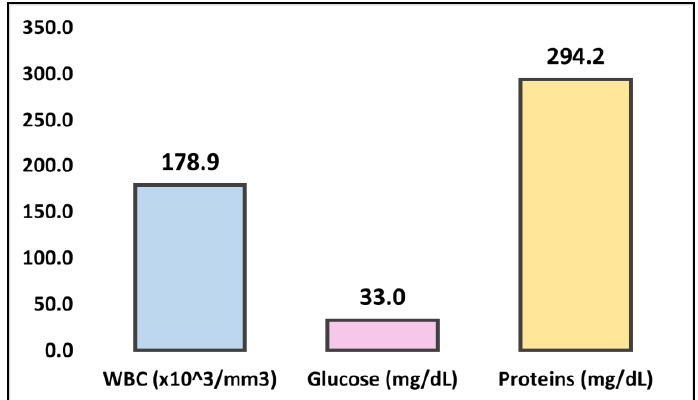
Figure 1. Summary of findings in CSF samples.